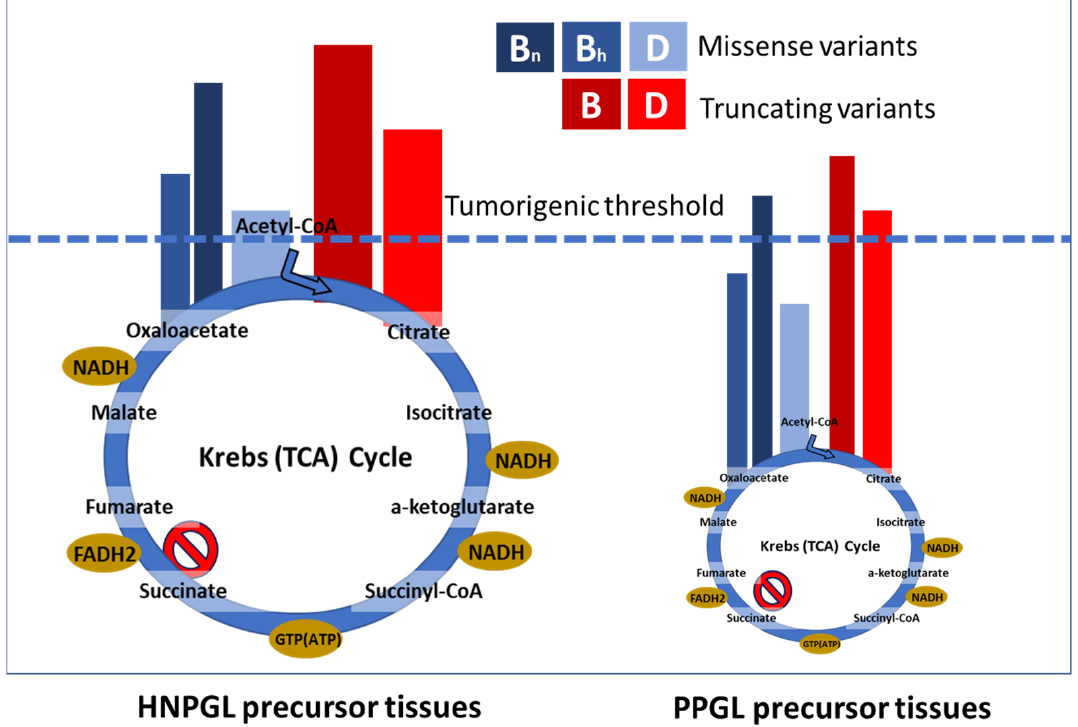
Figure 5. Illustration of scenario 2, the ‘succinate threshold’ model. We propose that succinate accumulation differs markedly between hypomorphic (missense) and null (truncating) alleles. The high succinate levels intrinsic to parasympathetic HNPGL tissues raise cells closer to the tumorigenic threshold compared to sympathetic PPGL precursor tissues. The size of the depicted Krebs cycle approximates the difference in metabolic activity between tissue types. While most SDHC and SDHD variants appear to fall clearly into the expected functional class (with some variation), we predict that many SDHB missense variants are null alleles functionally equivalent to truncating variants (B, SDHB; Bh, SDHB hypomorphic; Bn, SDHB null; D, SDHD).